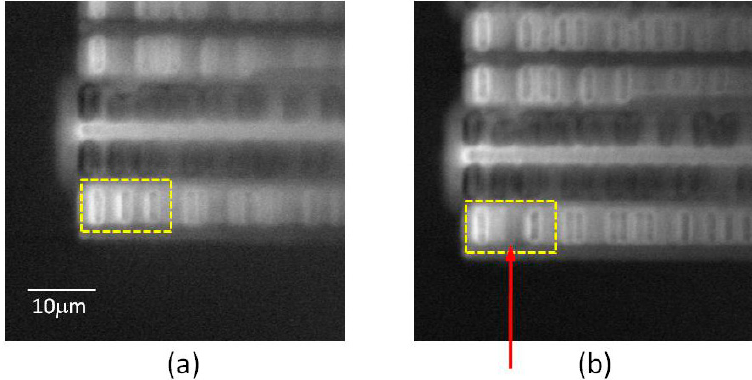
Figure 17. LTEM images of a functioning circuit ( a ) and a defective one ( b ). The arrow shows the location of the broken contact. Brighter areas indicate stronger THz emission. Reprinted with permission from [109] © The Optical Society.